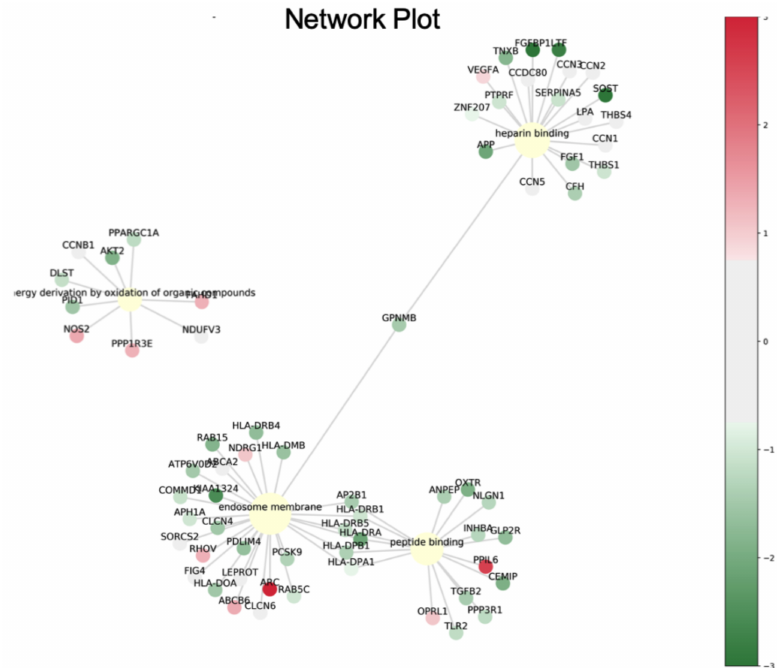
Figure 6. Pathway network of the proteins differentially expressed in response to luteolin treatment. The top 20 KEGG pathways enriched in the dysregulated genes were identified using mRNA sequencing data. The tuberculosis ( p = 0.00003), human T-cell leukemia virus 1